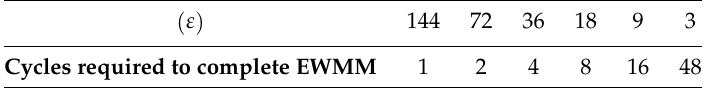
Figure 10. Design of processing unit. Table 2. Concurrency vs. throughput for EWMM (in the case of the 6 × 6 sized